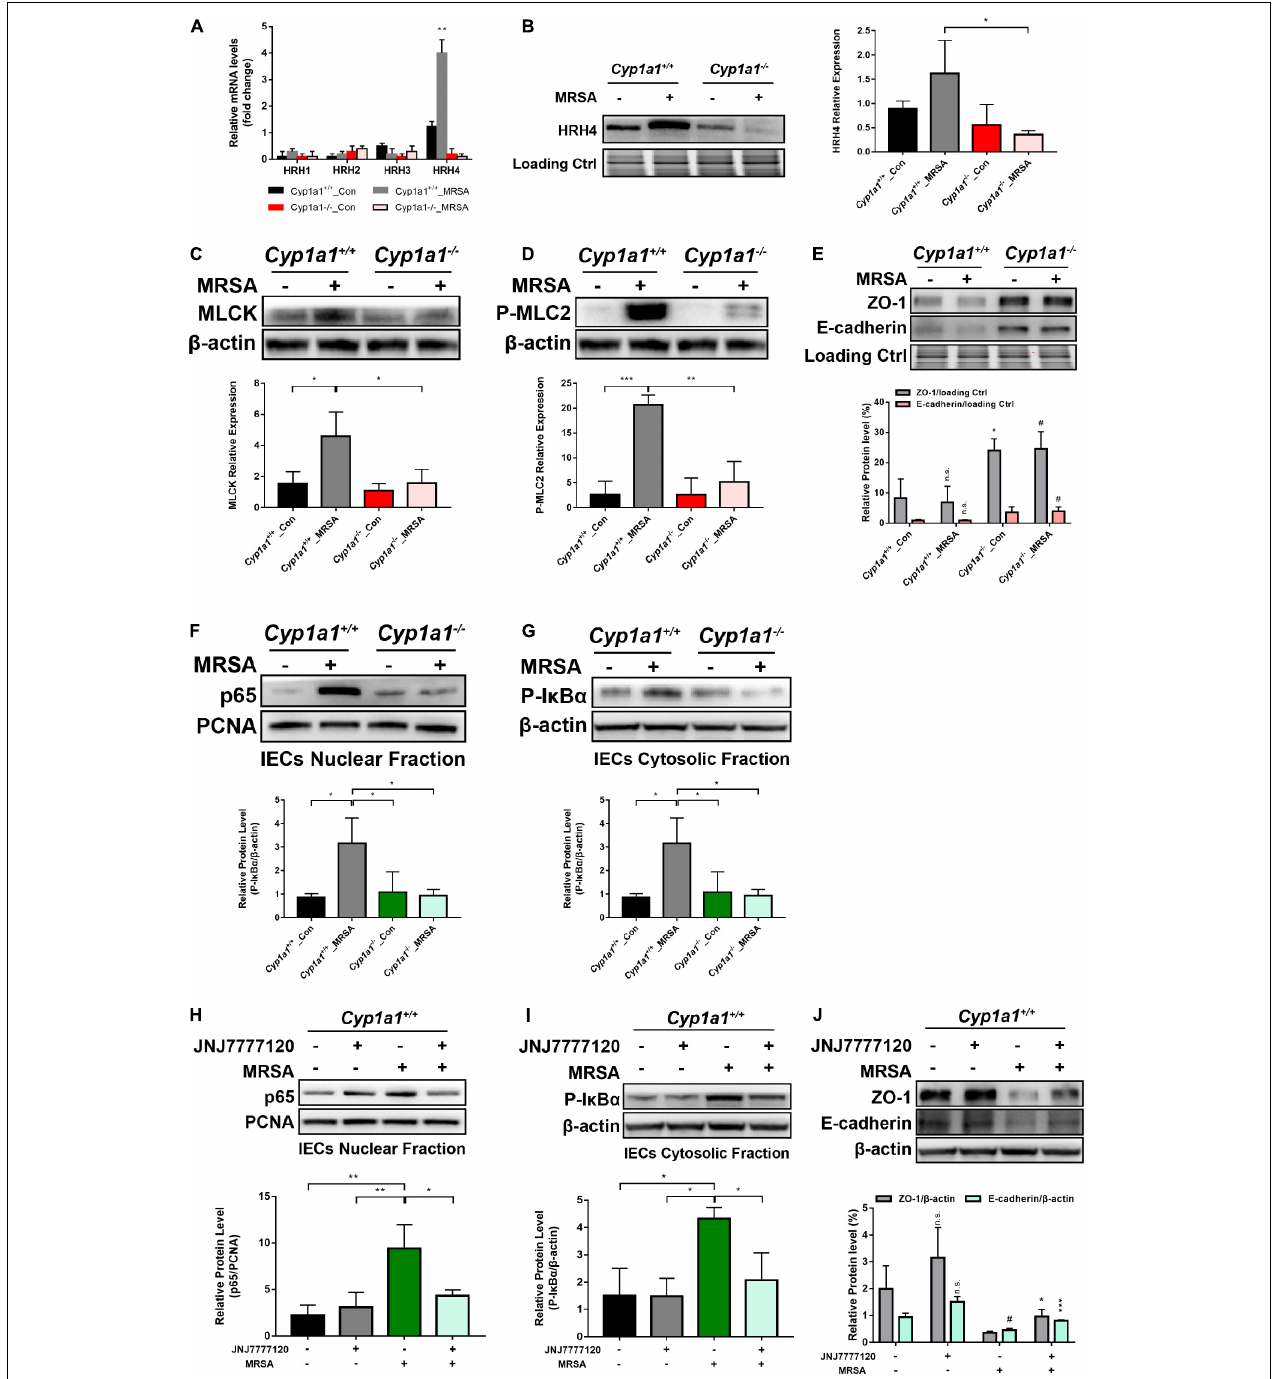
FIGURE 6 | Microbiota-derived CAD induces gut barrier disruption through HRH4/NF- κ B/MLCK activation. (A) Relative mRNA expression of HRH1, HRH2, HRH3, and HRH4 in the ileal epithelium from each group ( n = 3–4). (B) Immunoblot and densitometry plots of the MRSA-induced HRH4 levels in the ileal epithelium from each group ( n = 5–6). (C,D) Immunoblot and densitometry plots of MLCK (C) and P-MLC2 (D) in whole-cell lysates of IECs from each group ( n = 5–6). (E) Immunoblot and densitometry plots of tight junction proteins in the ileal epithelium from each group ( n = 6–7). (F,G) Immunoblot and densitometry plots of the p65 levels in the nuclear extracts (F) and those of P-I κ B α levels in the cytosolic extracts (G) of IECs from two mice before or at 12 h p-Mi ( Cyp1a1 + / + mice, n = 6–7; Cyp1a1 − / − mice, n = 6–7). PCNA is a nuclear loading control. (H–J) Immunoblot and densitometry plots of the p65 levels in the nuclear extracts (H) , P-I κ B α levels in the cytosolic extracts (I) , and tight junction protein levels in whole-cell lysates (J) of IECs from each group ( n = 6–7). Error bars, ± SEM. Differences were analyzed using one-way ANOVA. * P < 0.05, ** P < 0.01, *** P < 0.001, n.s. not significant. # Comparison between Cyp1a1 + / + _MRSA and Cyp1a1 − / − _MRSA groups or between JNJ7777120 − MRSA + and JNJ7777120 + MRSA + groups. # P < 0.05.